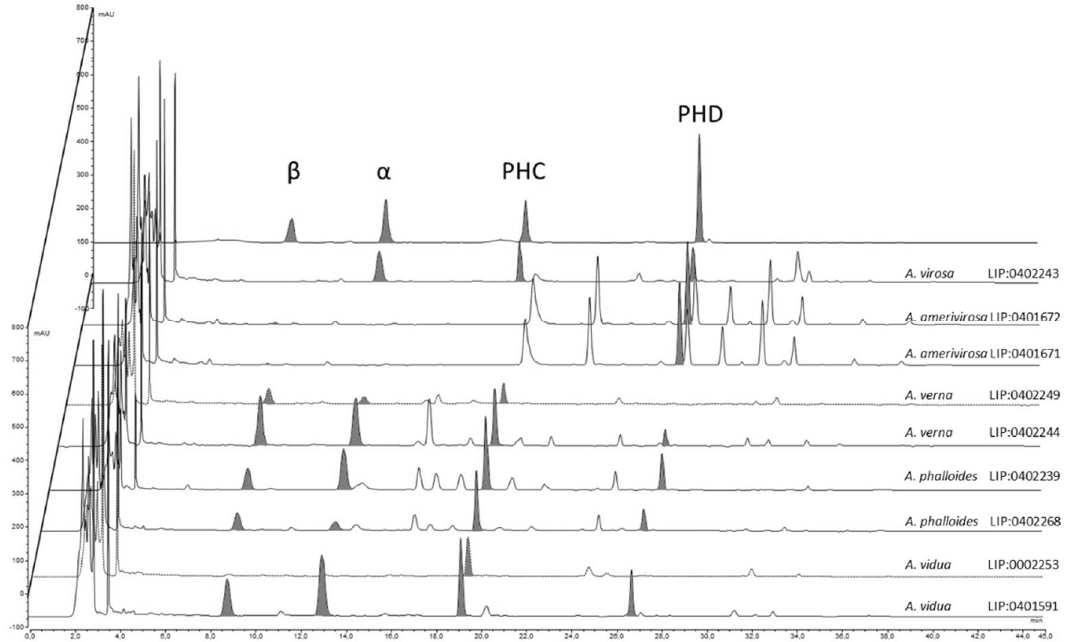
Figure 9. Contents of amatoxins and phallotoxins in the different species of Mediterranean ‘destroying angels’ inferred from phylogenetic analysis: α = α-amanitin, β = β-amanitin, PHC = phallacidin, PHD = phalloidin.